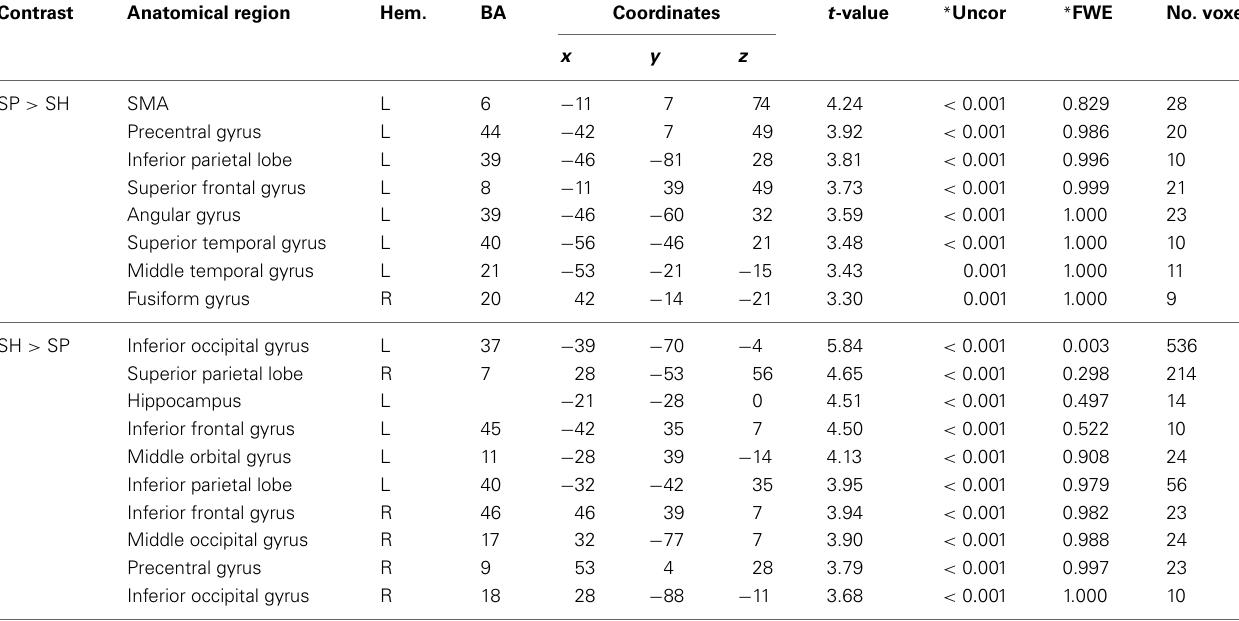
Table 4 | Main effects for space-related and shape-related semantic contents.